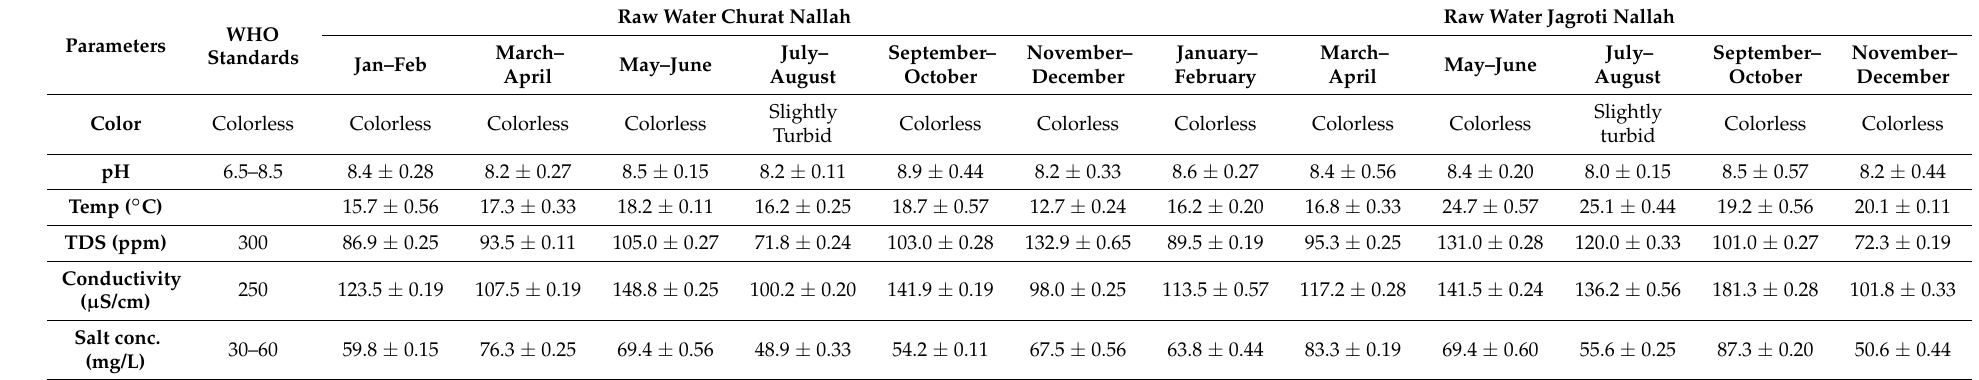
Table 1. Analysis of samples collected from source Churat/Jagroti Nallah.